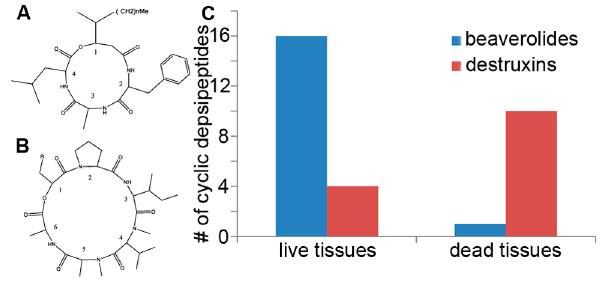
Figure 4. Overview cyclic depsipeptides identified in this study. A) General structure of beauverolides. The identities of the amino acids at positions 2–4 and the n descriptor are given in Table 1. B) General structure of destruxins. The identities of the amino acids at positions 2–6 and the R descriptor are given in Table 2. C) Bar chart summarizing the amount of beauverolides (blue) and destruxins (red) found to be secreted on live and dead insect tissues.